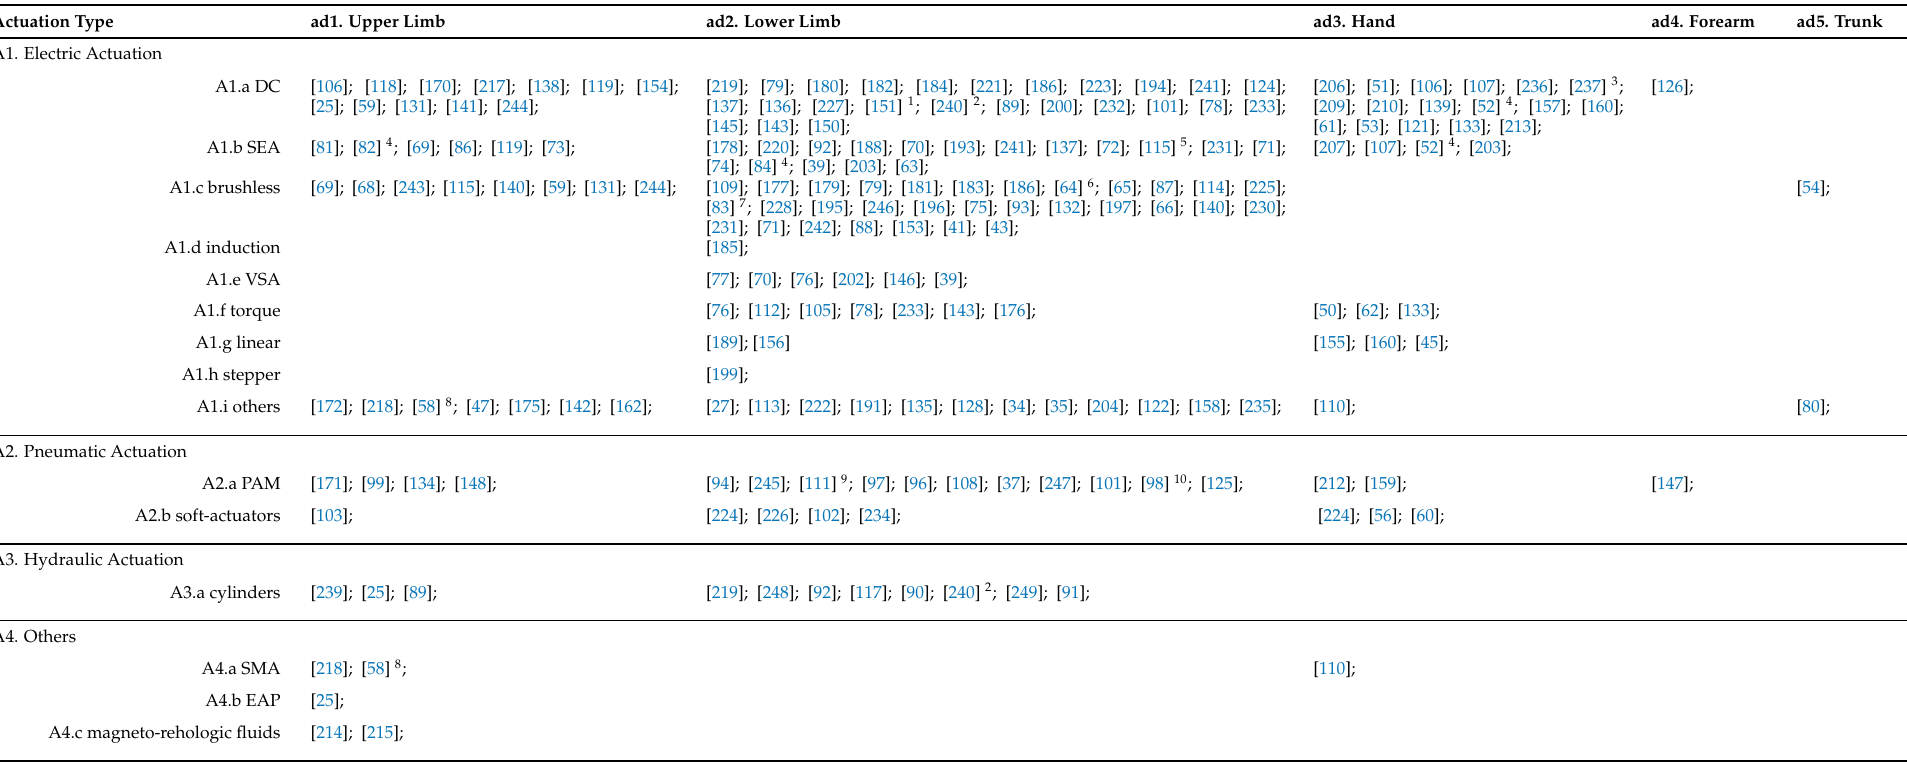
Table A2. Cross analysis of the paper distribution of power source vs. anatomical district (DC: Direct Current; SEA: Series Elastic Actuator; VSA: Variable